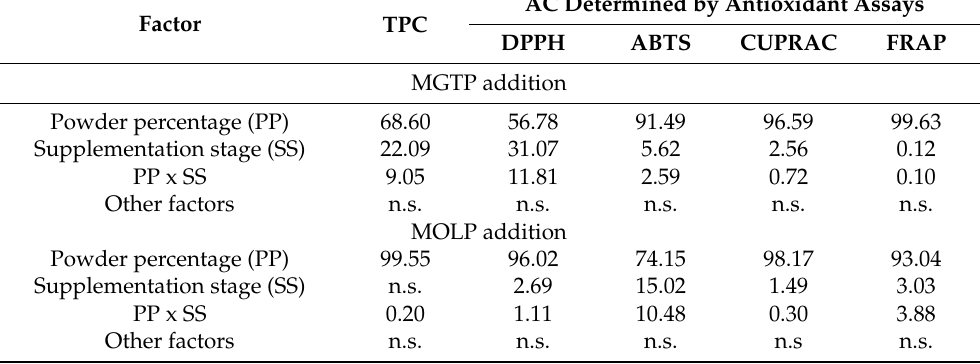
Table 6. Effect of matcha green tea powder and moringa leaf powder percentage and the stage of their addition (percentage of explained variance) on total phenolic content and antioxidant capacity of white chocolate.